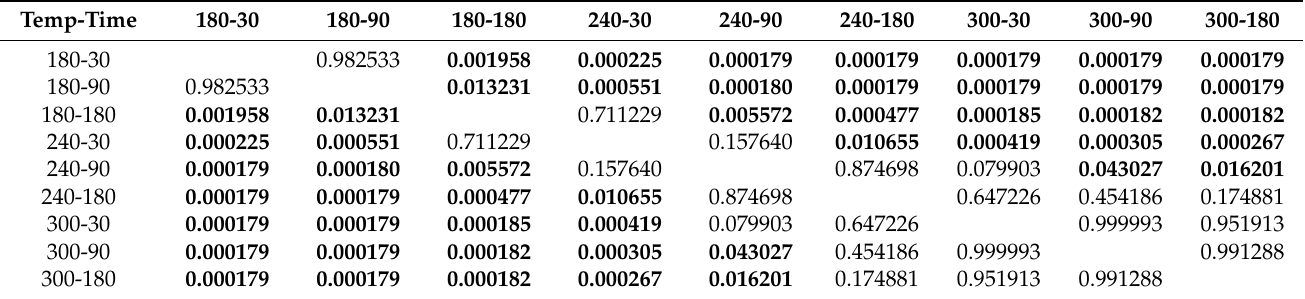
Table A12. Two-way analysis of variance (ANOVA) with post hoc Tukey test for H , a bold font signifies a statistically significant difference ( p < 0.05).